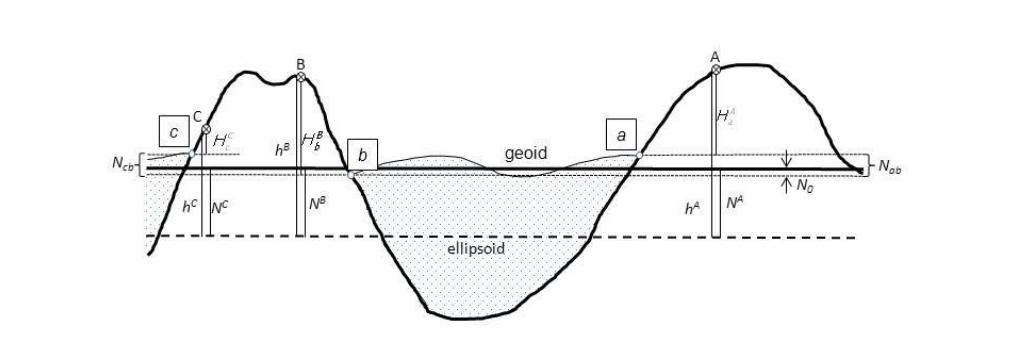
Figure 2. The basic situation is as in Figure 1. Now the orthometric heights are available as well, but each referring to a separate datum zone (a, b and c, respectively). Consequently one has to deal with the unknown height offsets between the datum zones and their common offset relative to the